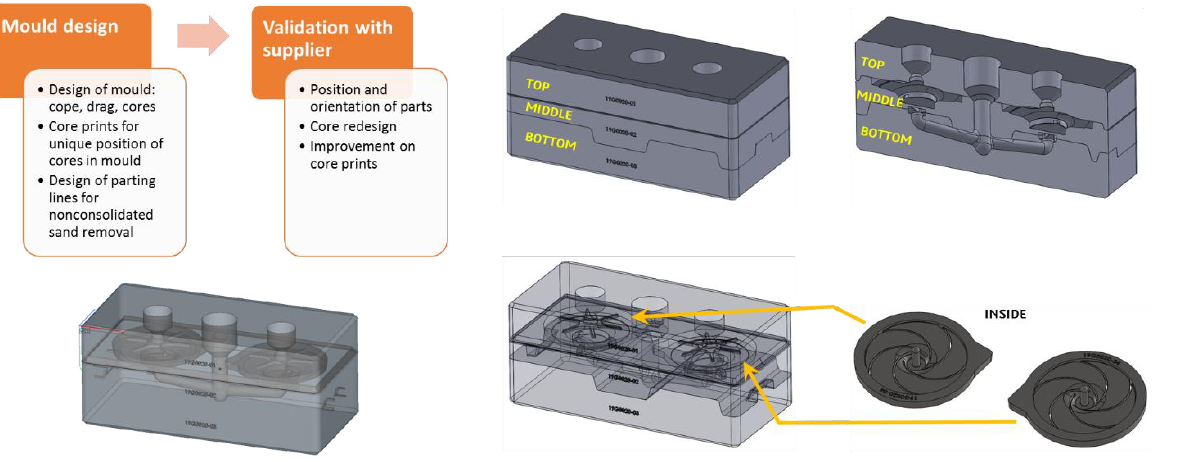
Figure 2. Design and manufacturing of the sand